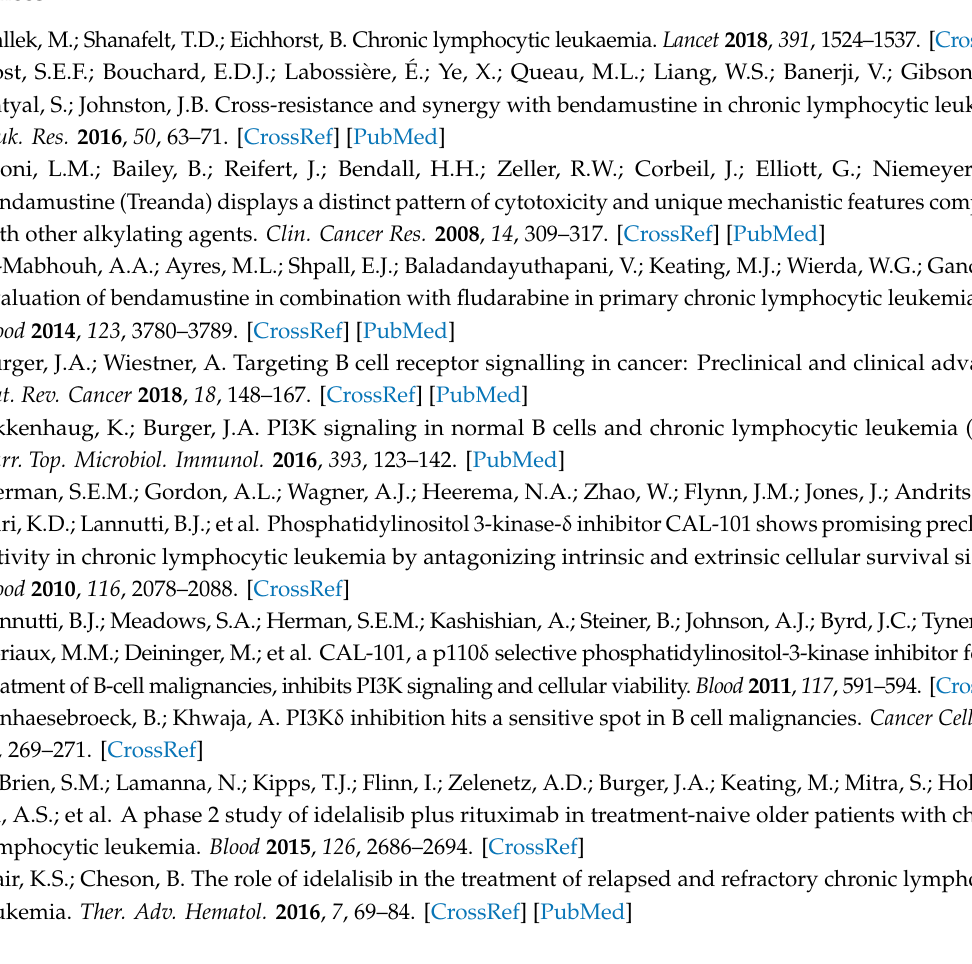
Table S1: Antibodies used for western blot analysis, Figure S1: Synergy between IDE and BEN was not seen in B cells from mice with non-functional PI3K δ protein, Figure S2: Induction of γ H2AX foci by IDE in non-B cell lineage cell lines, Figure S3: IDE decreases p-AKT levels post stimulation even in the presence of